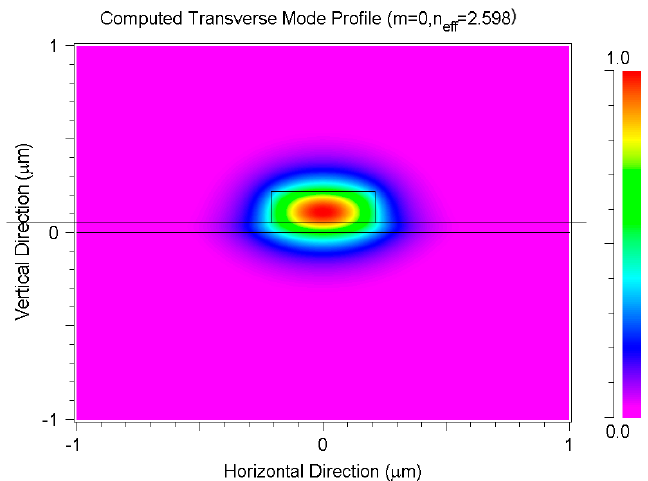
Figure 2. The fundamental TE-mode field and effective refractive index of SiGe-OI optical waveguide at the wavelength of 1.55 μ m.